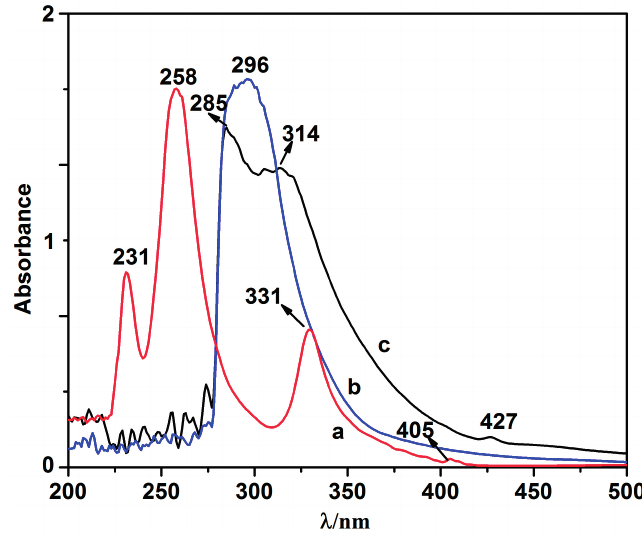
Figure 2. UV-Vis spectra of ( a ) C 60 , ( b ) bromomalonic acid glycidyl azide polymer ester (BM-GAP) and ( c ) C 60 -GAP.